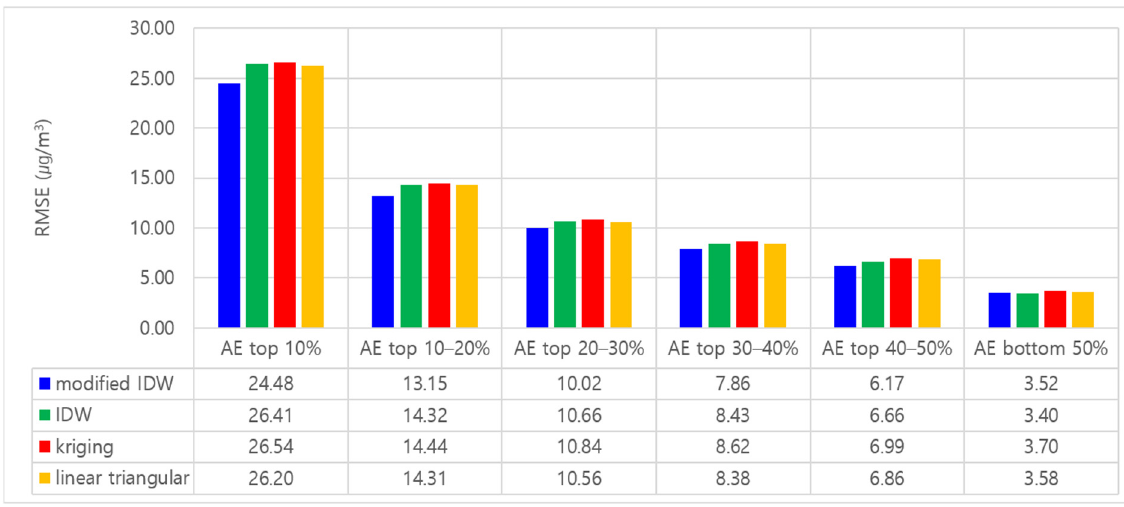
Figure 7. RMSE of estimated PM10 for different algorithms based on AE levels.